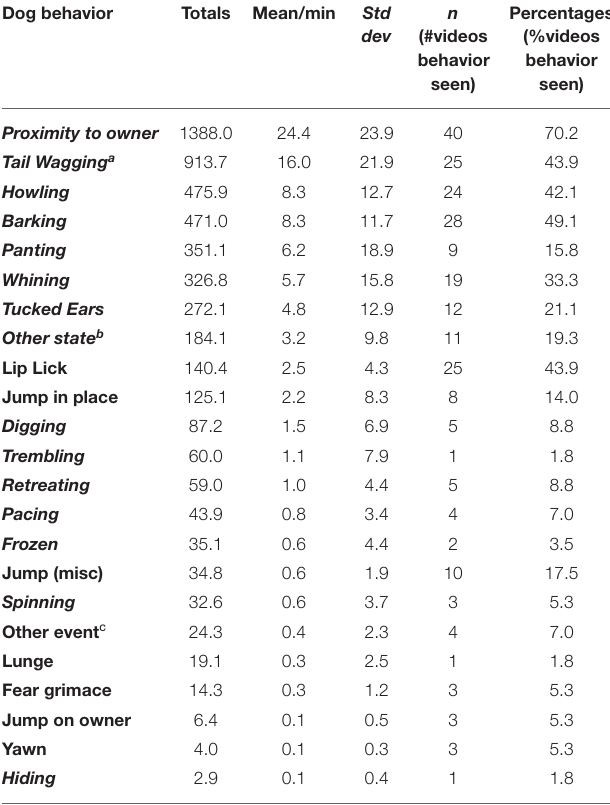
TABLE 6 | Behaviors recorded in the YouTube videos ( n = 57), in order of frequency. Dog behavior Totals Mean/min Std Proximity to owner 1388.0